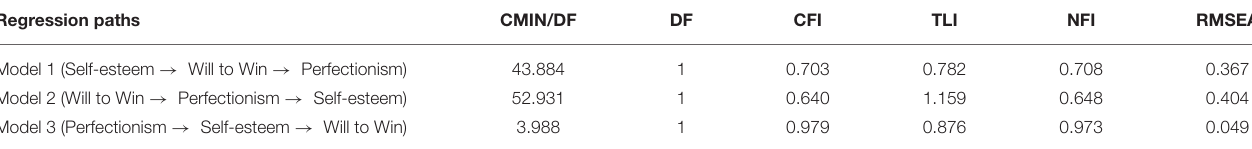
TABLE 4 | Measurement model. Regression paths